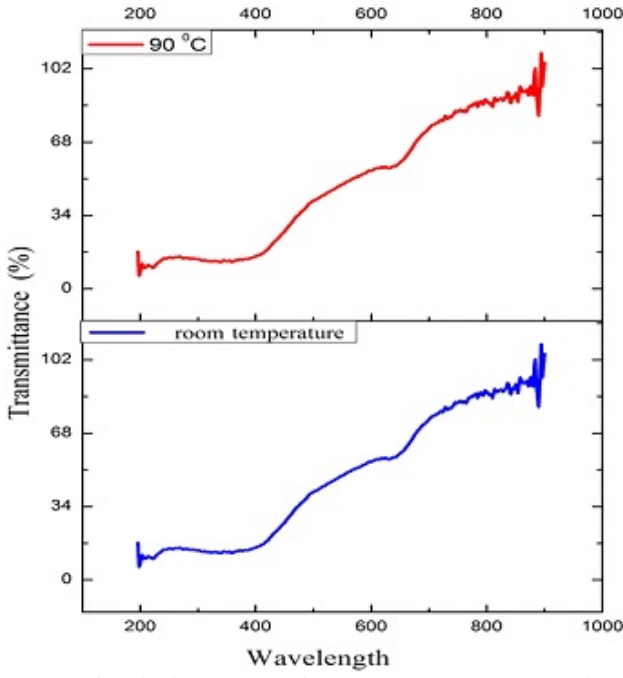
Fig. 5. DRS chart the absorption rate of ZnO NPs at room temperature and